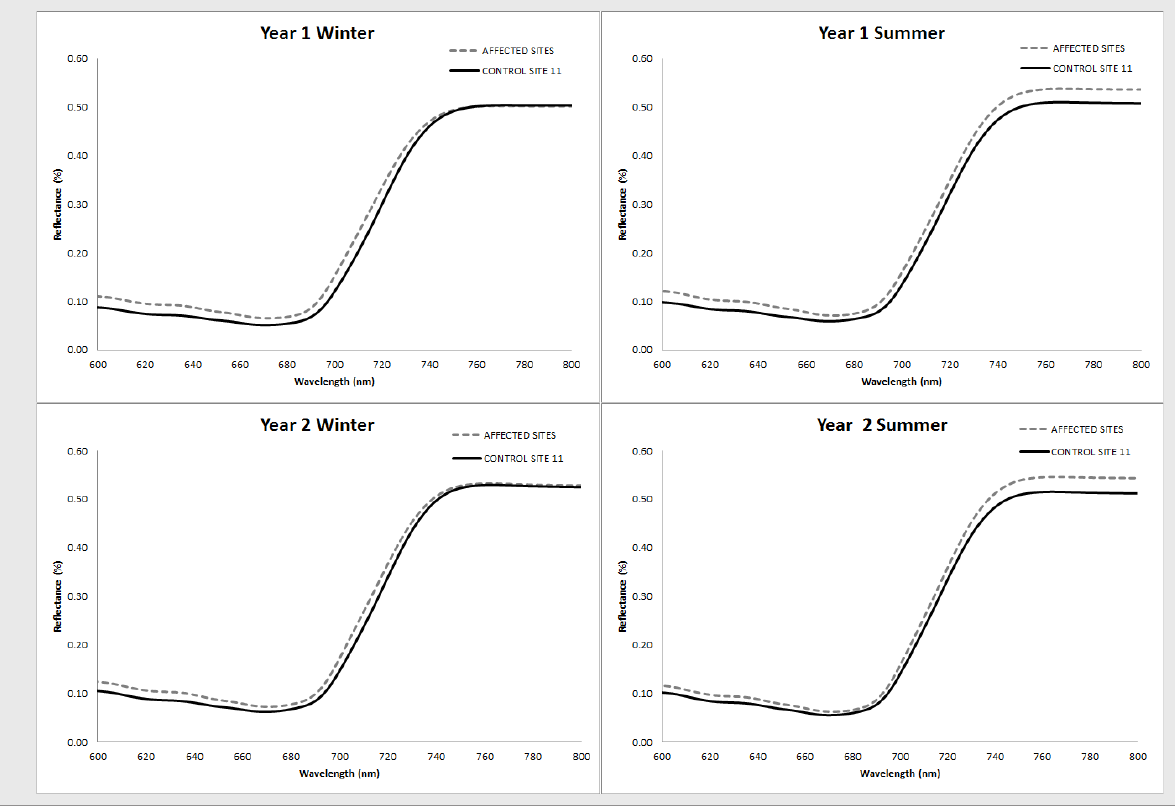
Figure 3: The chlorophyll red edge region for affected sites and the control